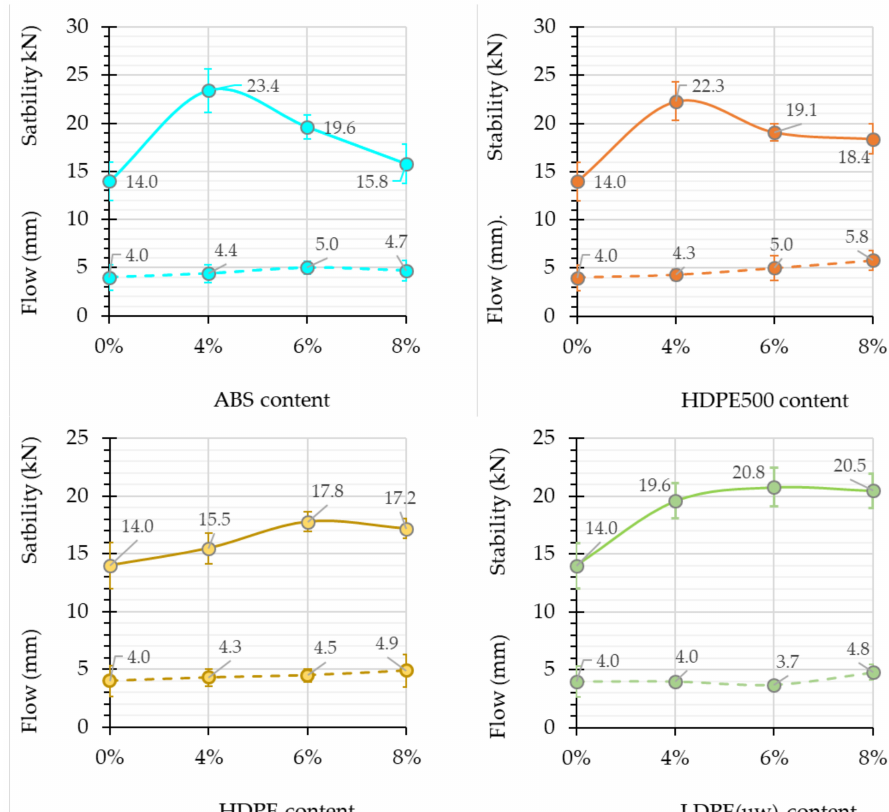
Figure 7. Marshall stability and flow as a function of plastic waste content.